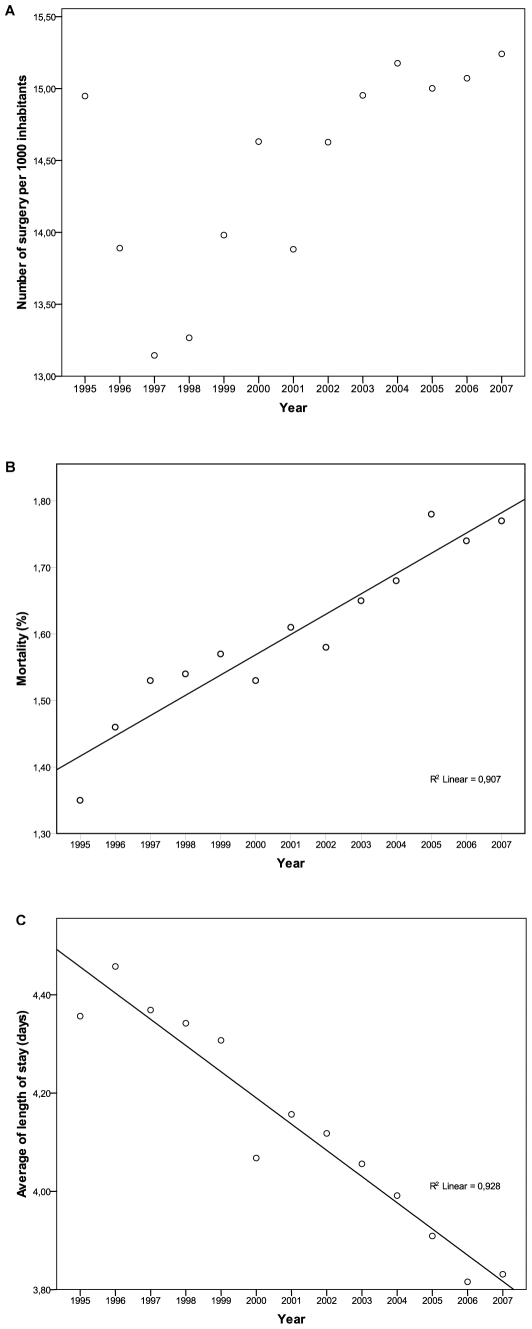
Trends analysis results.A- Number of surgery per 1,000 inhabitants. B – Mortality. C- Length of Stay.